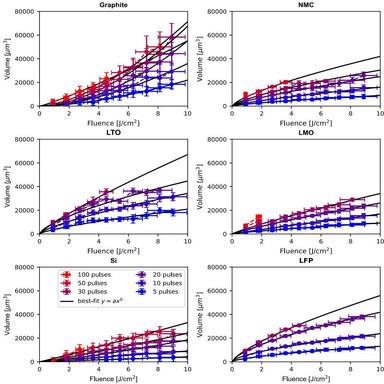
Plots of average pore volume as a function of pulse fluence with corresponding best-fit power-laws. Best-fit parameters are specified in